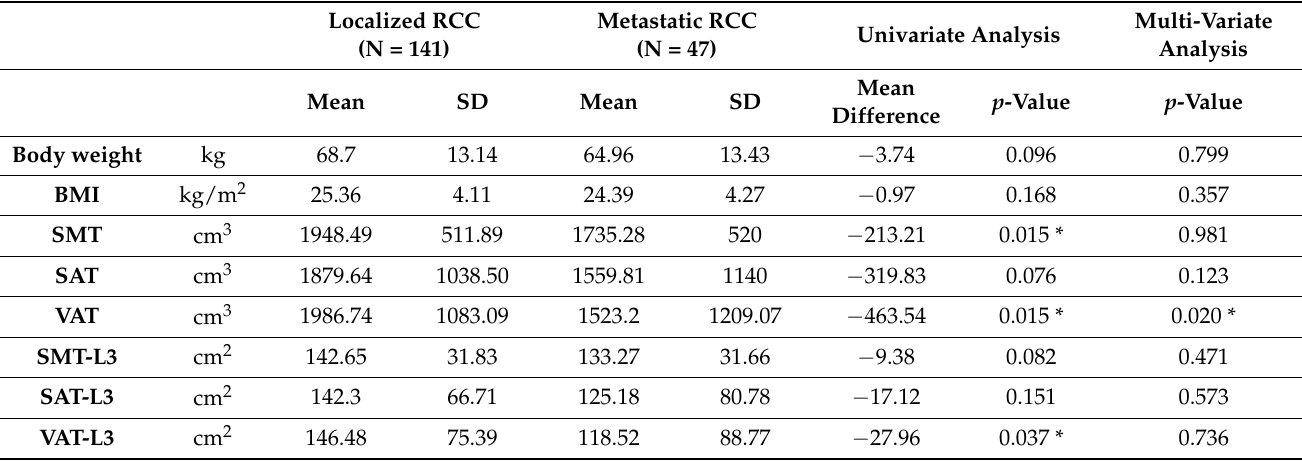
Table 2. Significant difference analysis between localized and metastatic RCC.